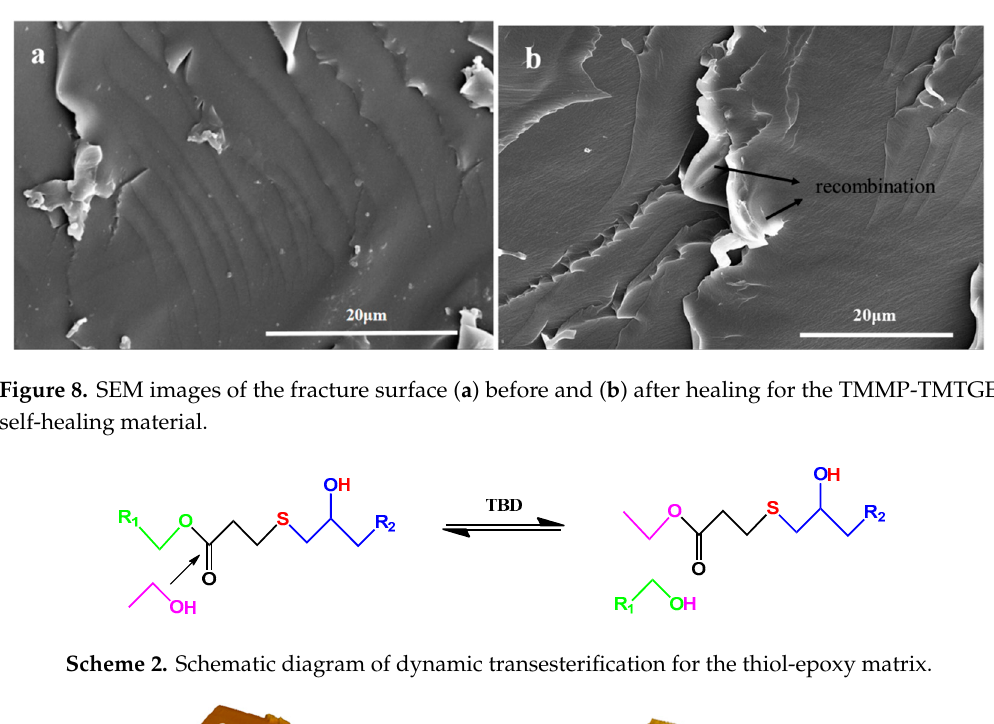
Figure 8. SEM images of the fracture surface ( a ) before and ( b ) after healing for the TMMP-TMTGE Scheme 2. Schematic diagram of dynamic transesterification for the thiol-epoxy matrix. self-healing material. Figure 9. AFM images of scratch after healing for the ( a ) TMMP-TMTGE self-healing material and ( b ) TO/TMMP-TMTGE self-healing composite.